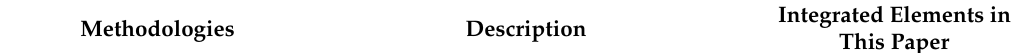
Table 1. Methodologies that summarizes the underlying elements integrated in this